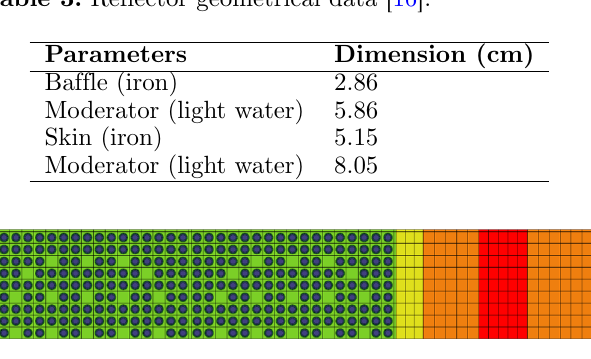
Table 4. Diffusion database fuel perturbations.